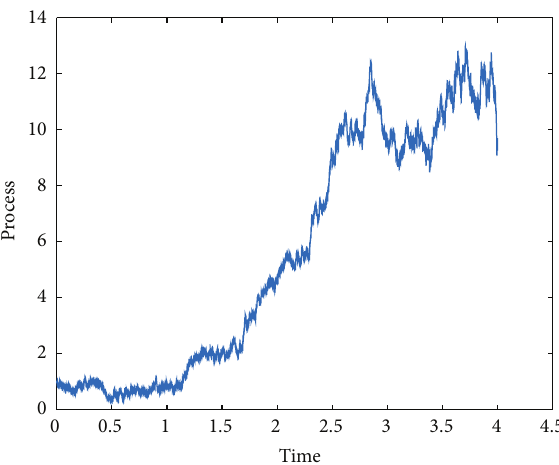
Figure 2: Diffusion approximation with epsilon =